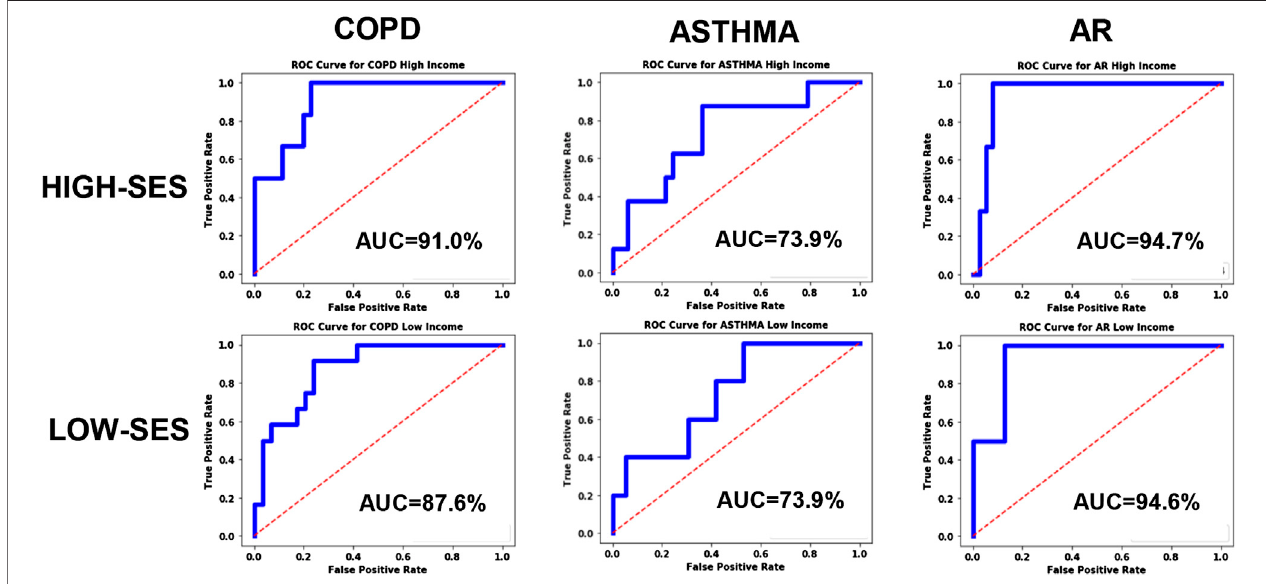
FIGURE 7 | ROC curves for the disease models corresponding to COPD, Asthma and AR as a function of socio-economic status.